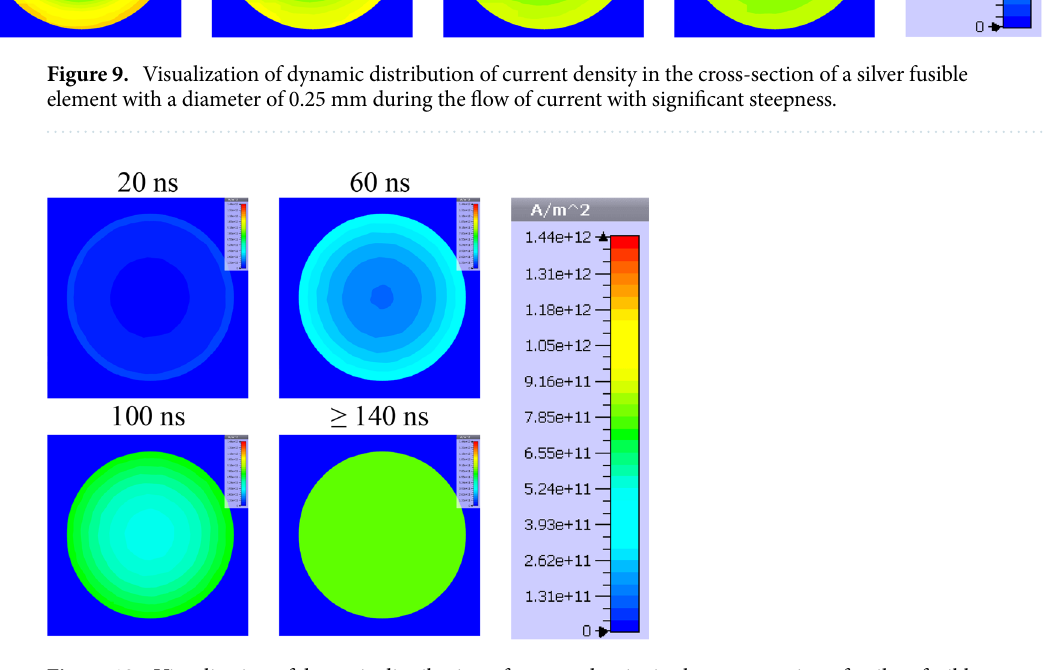
Figure 10. Visualization of dynamic distribution of current density in the cross-section of a silver fusible element with a diameter of 0.125 mm during the flow of current with significant